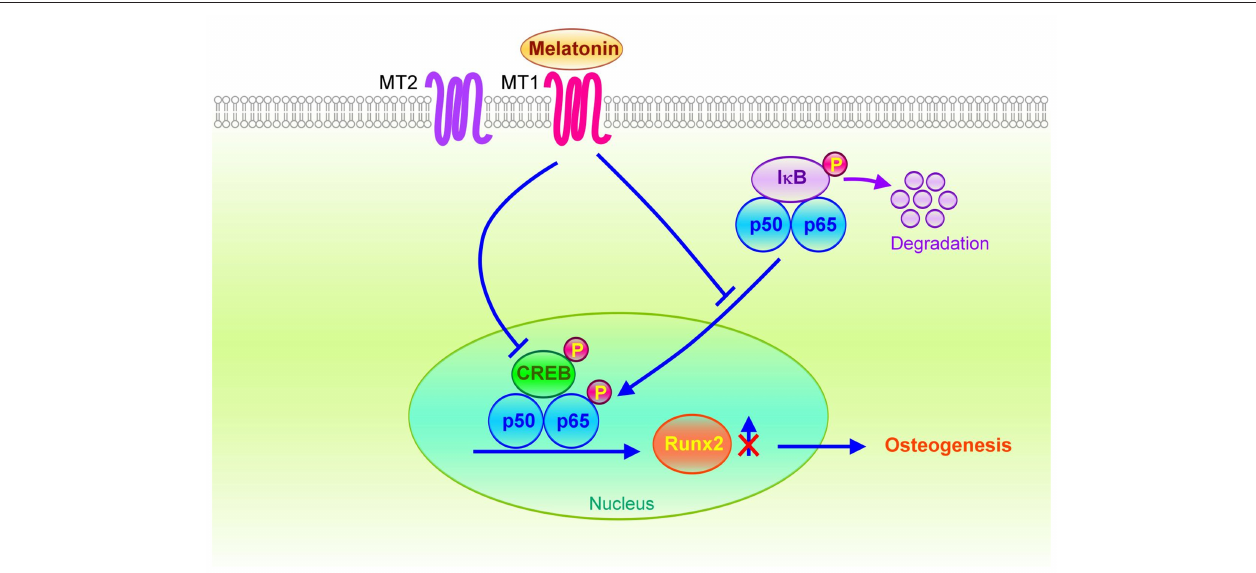
FIGURE 7 | Schematic of the potential mechanisms for the therapeutic effects of melatonin on osteogenesis in VICs. The melatonin/MT1 axis may downregulate Runx2 expression through inactivation of NF- κ B/CREB signaling in OST medium-treated VICs. Conversely, activation of the NF- κ B/CREB complex may bind to the Runx2 promoter to increase Runx2 gene transcription through VIC